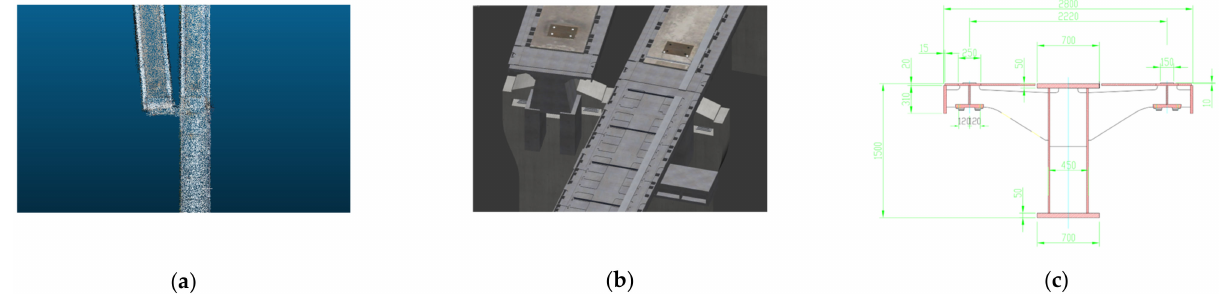
Figure 15. Local details of turnout structure: ( a ) dense point clouds model; ( b ) BIM model; ( c ) standard cross-sectional turnout structure